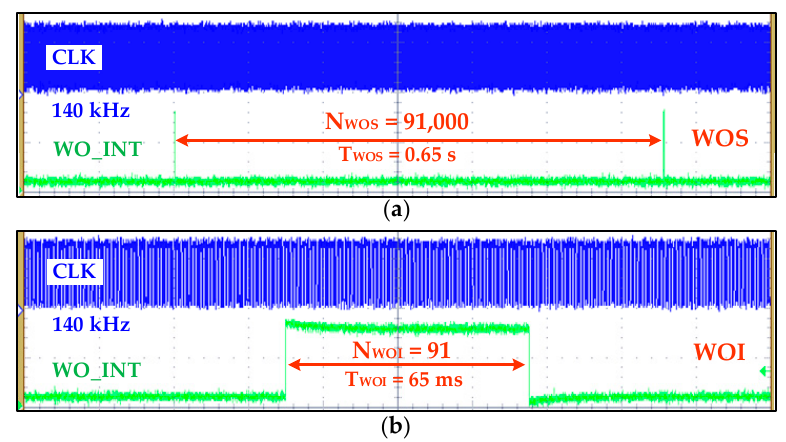
Figure 18. Wake-on mode measurement result: ( a ) Wake-on sleep of 0.65 s duration when N WOS is configured with value of 91,000; ( b ) wake-on interrupt of 65 ms when NWOI is configured as 91.